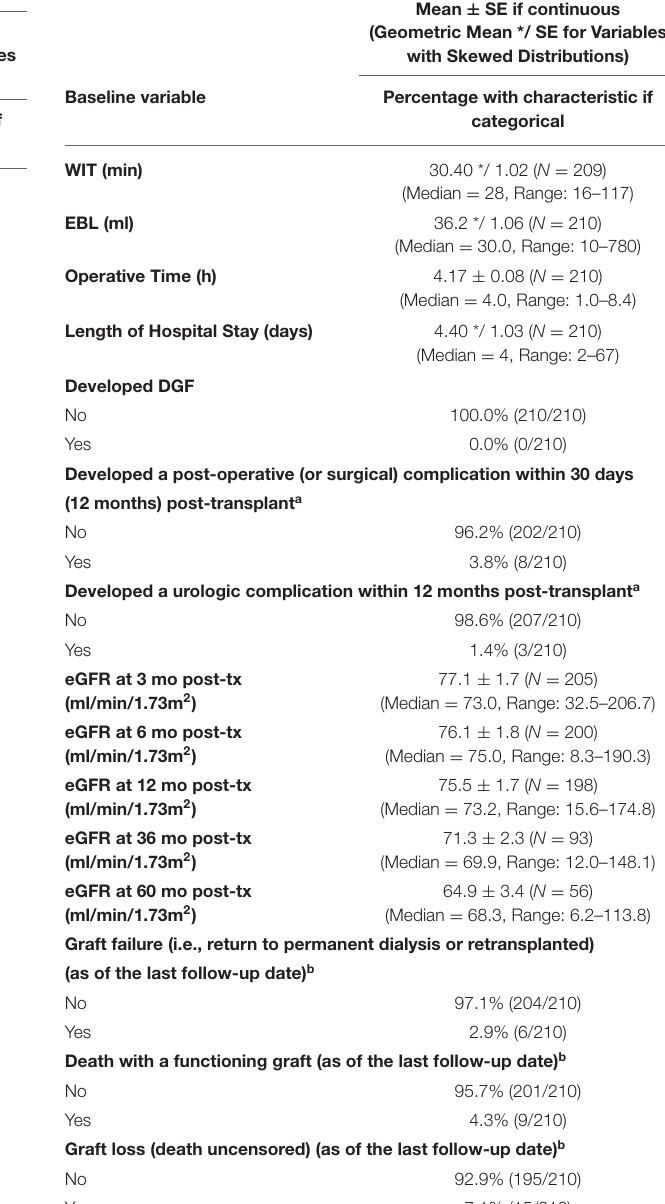
Mean ± SE if continuous (Geometric Mean */ SE for Variables with Skewed